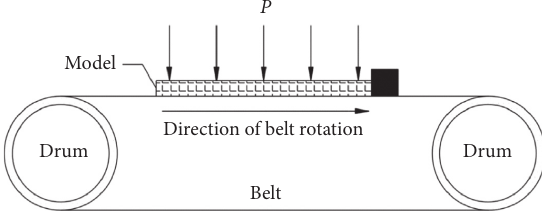
Figure 5: Bottom friction